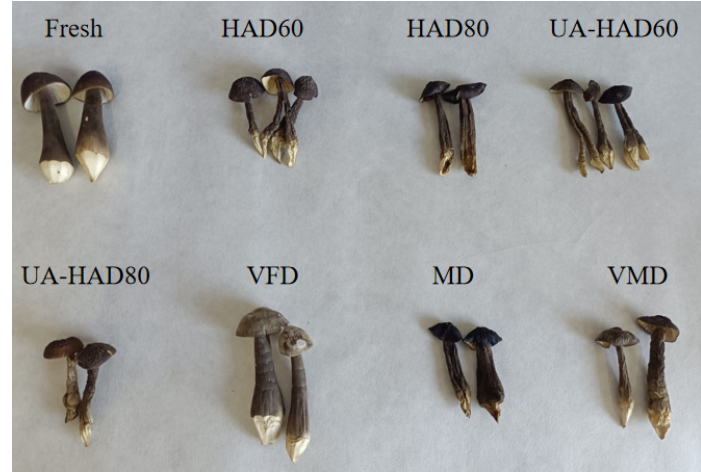
Figure 1. Macroscopic photo of fresh O. raphanipes and after drying, HAD60—60 ◦ C hot air drying, HAD80—80 ◦ C hot air drying, UA-HAD60—ultrasonic-assisted 60 ◦ C hot air drying, UA-HAD80—ultrasonic-assisted 80 ◦ C hot air drying, VFD—vacuum freeze drying, MD—microwave drying, VMD—vacuum microwave drying.